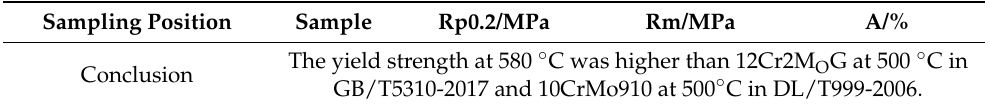
Table 6. Cont. Sampling Position